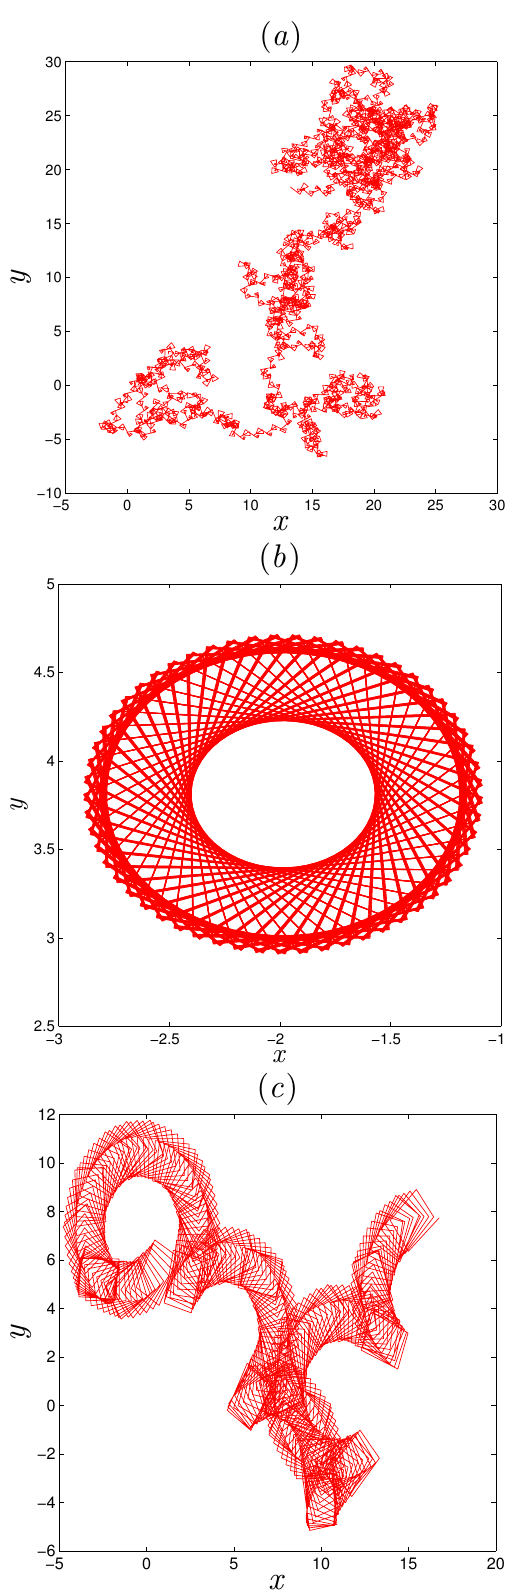
Figure 5. Dynamics of the translation components p − q for the fractional order map (6) different values of ν : ( a ) ν = 0.0852, ( b ) ν = 0.2931, ( c ) ν =